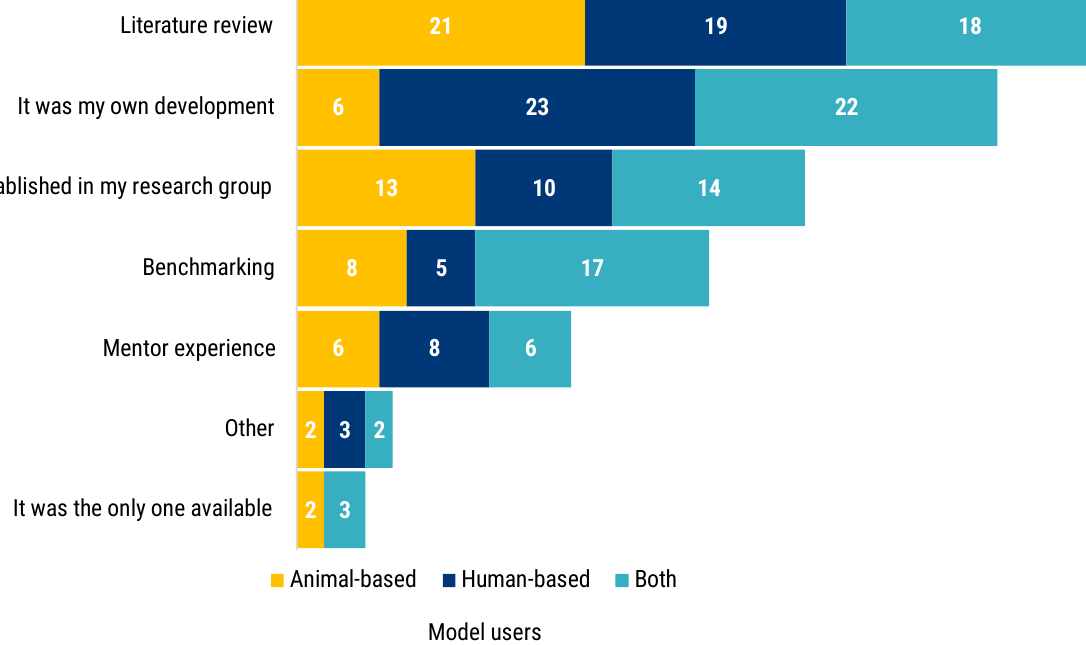
Figure 2. Participants answered the following question “How did you choose or establish your main experimental model?”. The stacked bar chart shows the frequency of each answer segmented by the researcher’s use of animal- (yellow) or human-based (blue) or both models (turquoise). Of those respondents who reported that the model in use was their own development, nineteen of them did not indicate reliance on any other method to establish their